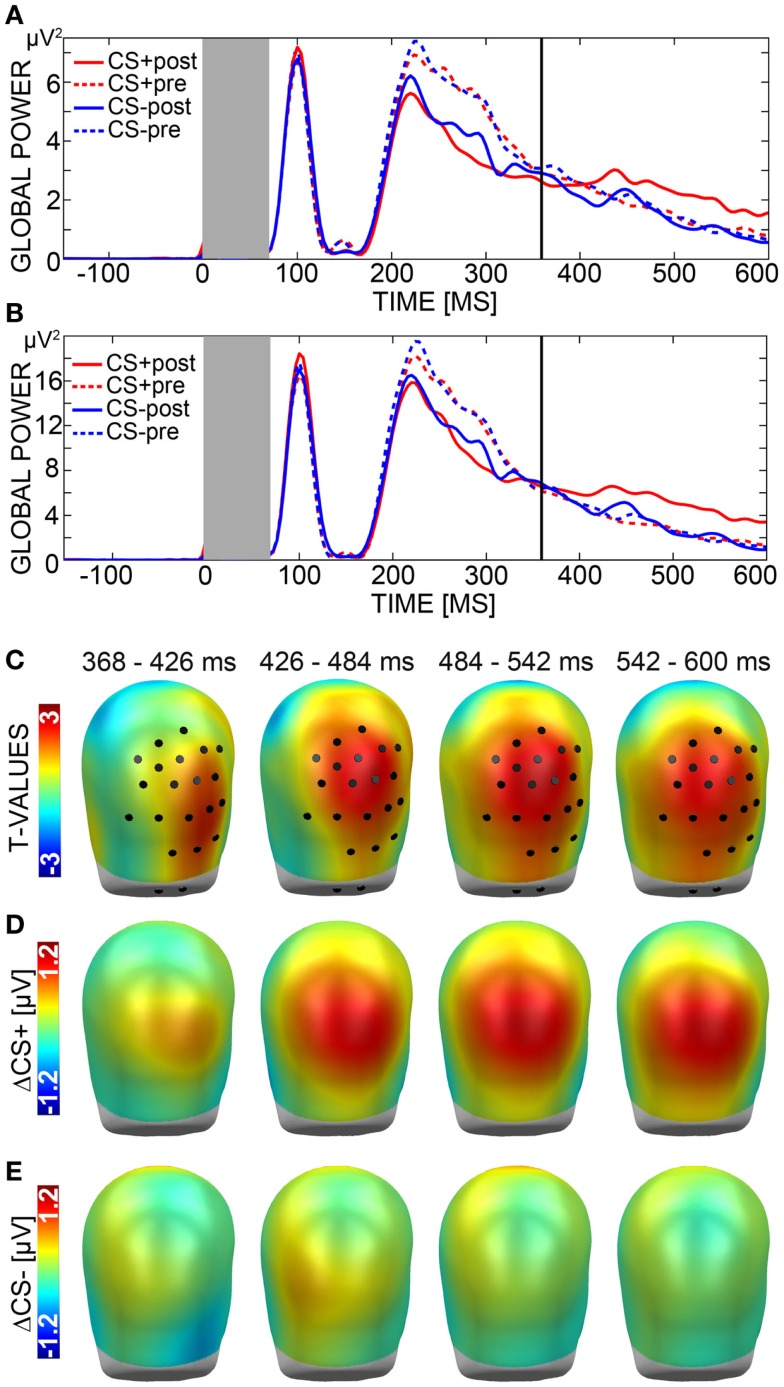
Electroencephalography (EEG). (A) The global power plot shows the mean activation of all sensors in response to aversively paired (CS+) faces after (red solid line) and before (red dotted line) learning as well as in response to unpaired (CS−) faces after (blue solid line) and before (blue dotted line) learning from 150 ms before to 600 ms after stimulus onset. The dark gray box marks the time window (0–70 ms) in which a trigger-related technical artifact occurred. Analysis was carried out across a typical time window of the late positive potential (LPP) ranging from 300 to 600 ms. The starting point of the time window (368–600 ms) in which the significant effect emerged is marked by a bold line. (B) Global power plot displaying the mean activation across significant sensors only, with labeling being equivalent to A. (C)
t-Values for the comparison of ΔCS+ (CS+post minus CS+pre) and ΔCS− (CS−post minus CS−pre) are plotted onto standard heads shown from back view. Black circles mark the sensor group displaying the significant effect during the selected time window (368–600 ms). (D) ΔCS+ and (E) ΔCS− are plotted onto standard heads shown from back view.